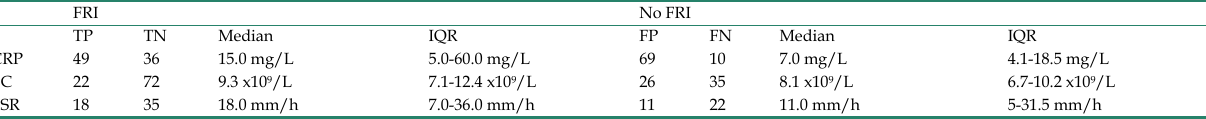
Table 3. CRP, LC and ESR.